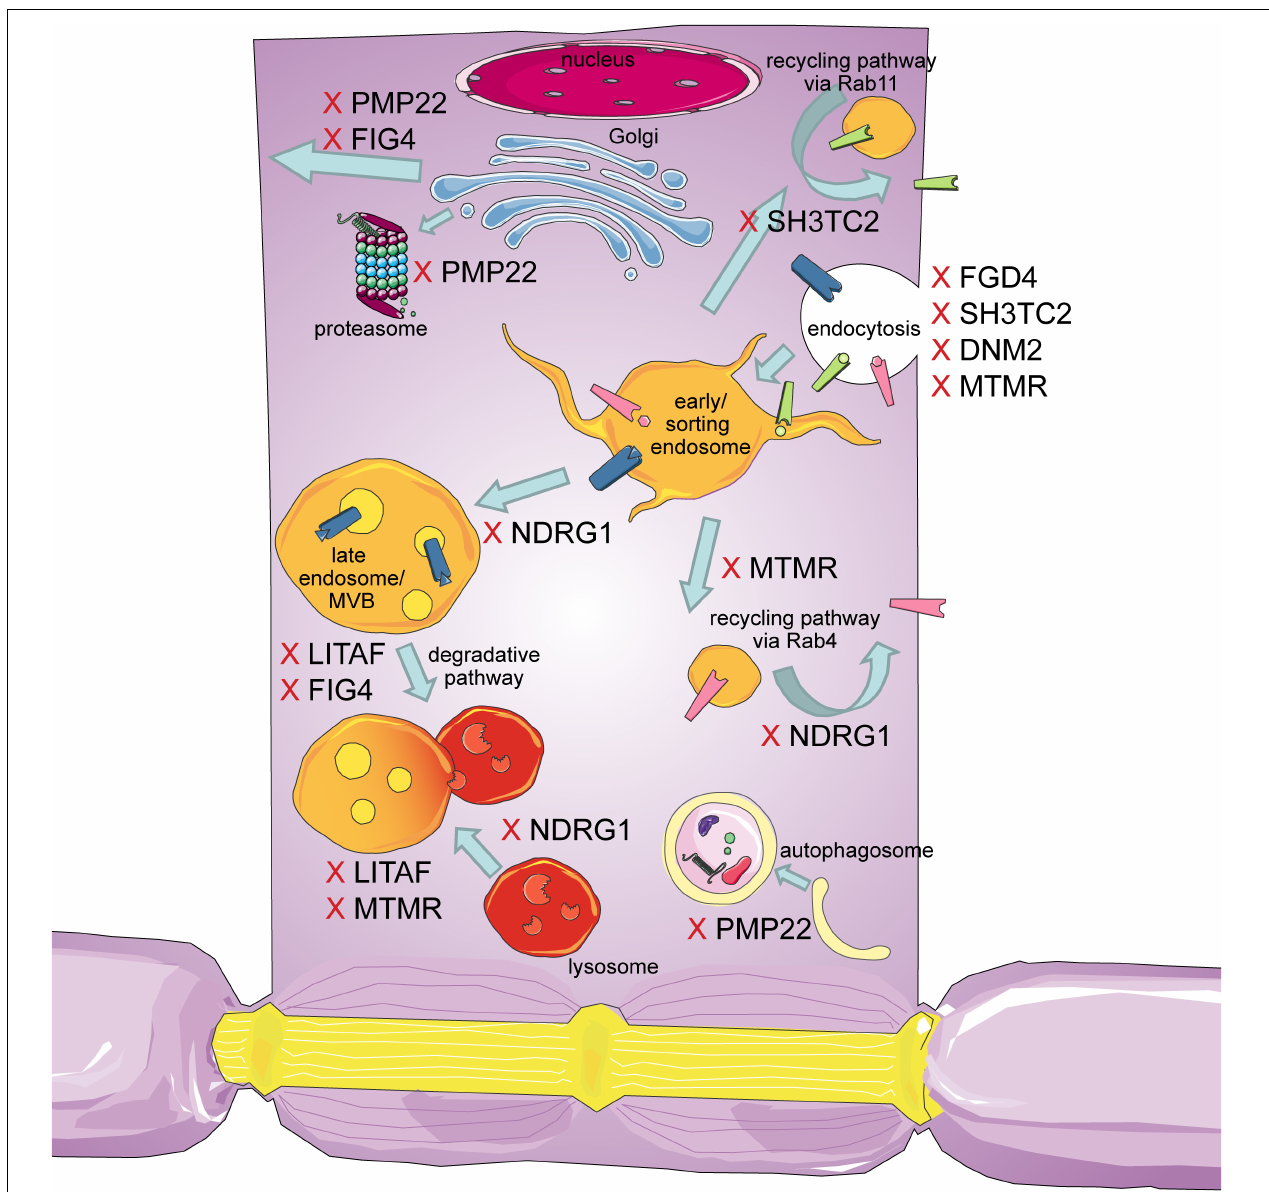
FIGURE 2 | Schematic overview of the intracellular trafficking processes in a myelinating Schwann cell. Highlighting all the steps where proteins involved in CMT can cause dysregulation. This figure was created using Servier Medical Art templates, which are licensed under a Creative Commons Attribution 3.0 Unported License;